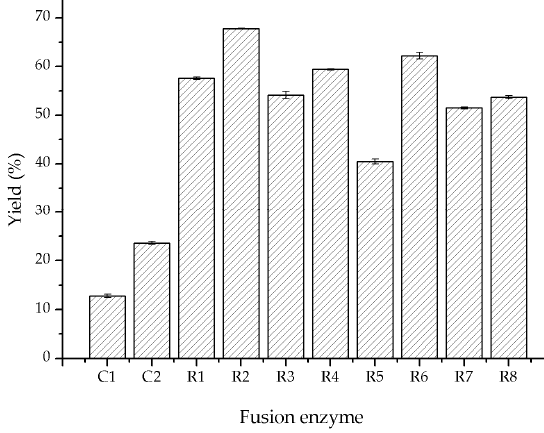
Figure 3. Comparison of different fusion enzymes on catalytic performance of alcohol oxidation. C1, So GOX alone as the control; C2, the control co-expressing So GOX, Hp CAT and Vs HGB separately; R1, Vs HGB-GSG- So GOX-GSG- Hp CAT; R2, Vs HGB-GSG- So GOX-GGGGS- Hp CAT; R3, Vs HGB-GGGGS- So GOX-GSG- Hp CAT; R4, Vs HGB-GGGGS- So GOX-GGGGS- Hp CAT; R5, Hp CAT-GSG- So GOX-GSG- Vs HGB; R6, Hp CAT-GSG- So GOX-GGGGS- Vs HGB; R7, Hp CAT-GGGGS- So GOX-GSG- Vs HGB; R8, Hp CAT-GGGGS- So GOX-GGGGS- Vs HGB. The reaction mixture (5 mL) contained 10 mg crude enzyme, 100 mM methyl glycolate, 0.01 mM FMN and 50 mM Tris-HCl (pH 8.0). The reaction at an oxygen aeration rate of 1 L/h was carried out at 25 °C and 600 rpm for 4 h. Table 2. Comparison of the wild type and the mutants on the concentration of evolved H 2 O 2 1 . Mutant Amino Acid Substitution